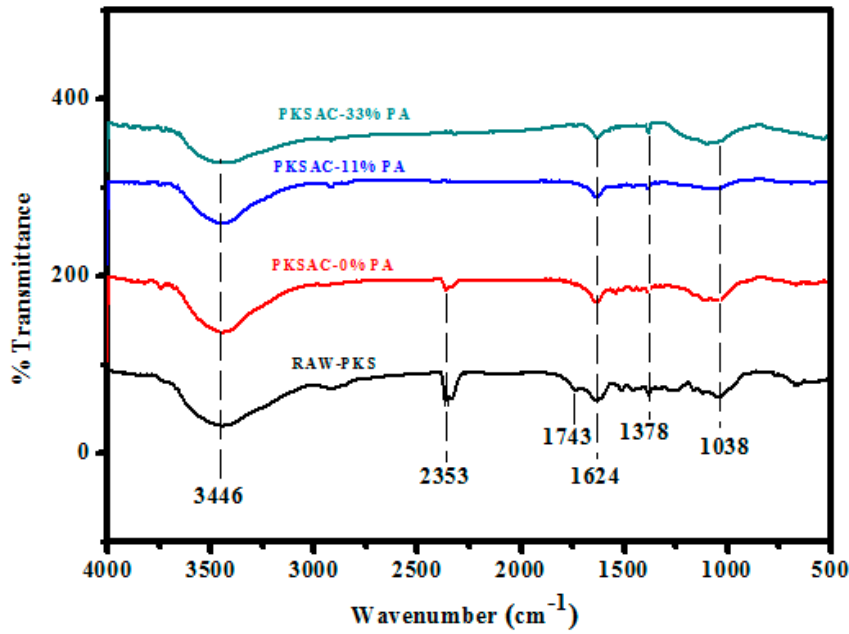
Figure 9. Fourier-transform infrared (FTIR) spectra of PKS-derived activated carbon, prepared using different concentrations of phosphoric acid.